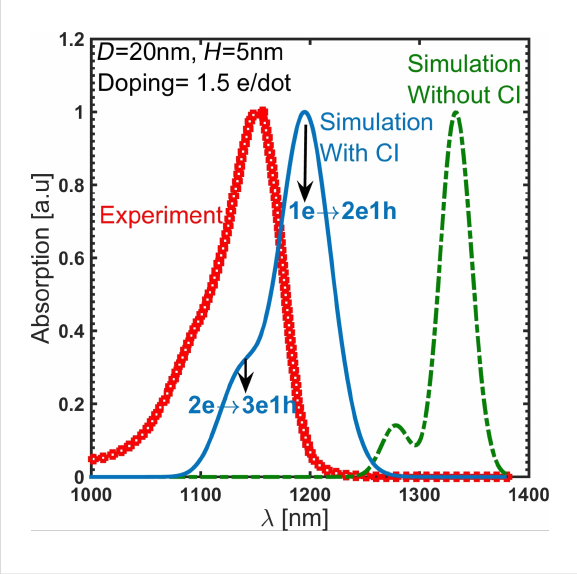
Figure 5: The simulated and the measured absorption spectrum of the QD system. The quantum dot is sample D from [11], which is a dome- shaped QD with a base diameter of 20 nm and height of 5 nm. The doping is 1–2 electrons per dot, which is assumed to be 1.5 here. The inclusion of many-particle configuration interaction (CI) to calculate the energy transitions significantly improves the agreement of the simula- tion and the experimental measurements. The higher peak corre- sponds to quantum dots occupying one electron (1e) transitioning to an excited state of two electrons and one hole (2e1h), while the lower peak corresponds to quantum dots occupying two electrons (2e) tran- sitioning to an excited state of three electrons and one hole (3e1h). The error is less than 3% in calculating the absorption peak photon energy.